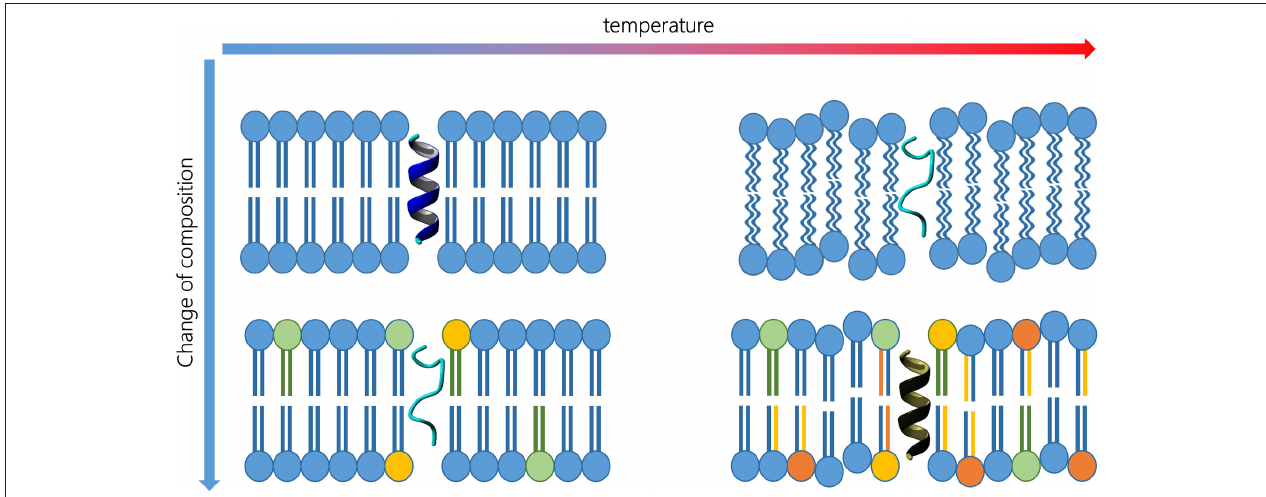
FIGURE 1 | Peptide activity is a function of its 3D structure, which, in turn, is influenced by membrane composition and external conditions (top left). Changes in lipid composition (bottom left) or temperature (top right) may alter the secondary structure. Proper changes in lipid composition and in the amino acid sequence may reverse the temperature increase effect, and therefore, recover the peptide activity (bottom